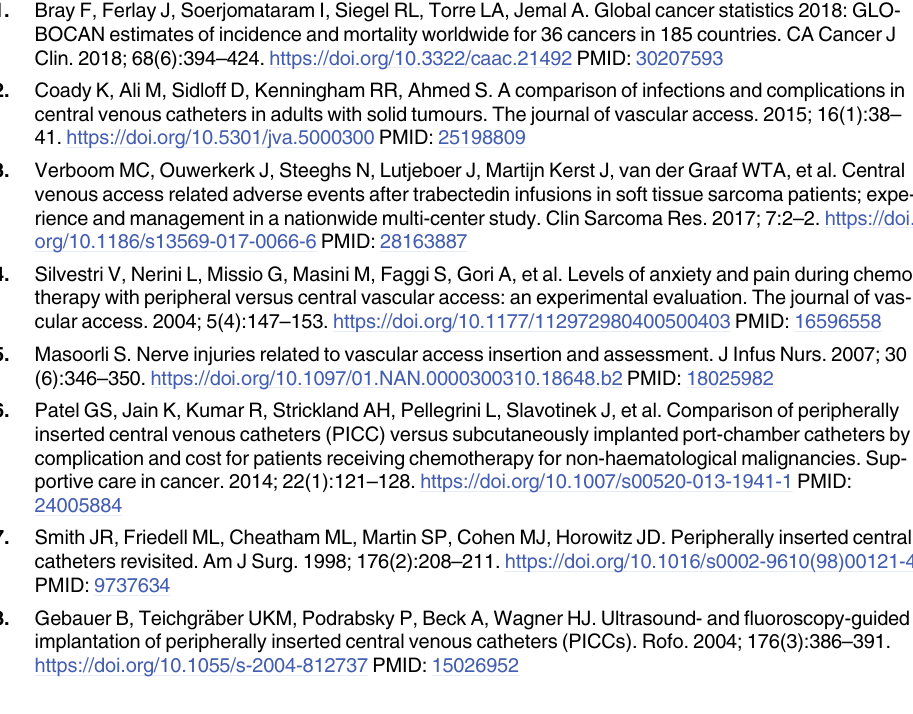
S1 Fig. Flow diagram of the searching processes and results in PUBMED. (TIF) S1 Table. PUBMED search strategies and